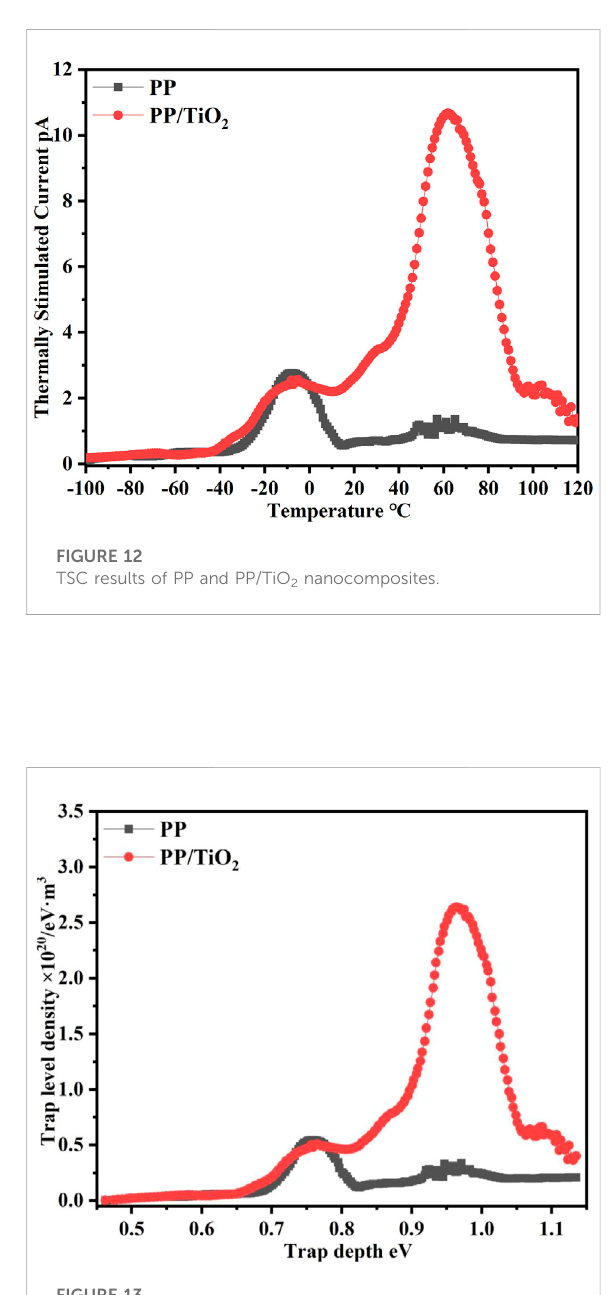
FIGURE 13 Trap depth distribution of PP and PP/TiO 2